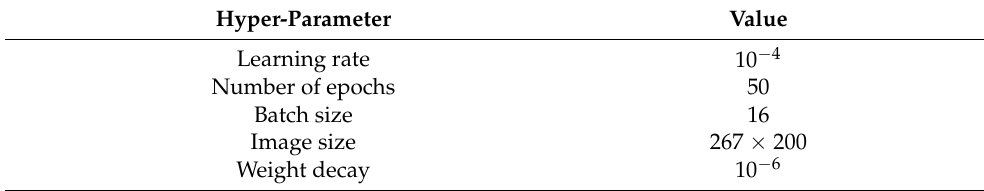
Table 1. Hyper-parameters used to train the